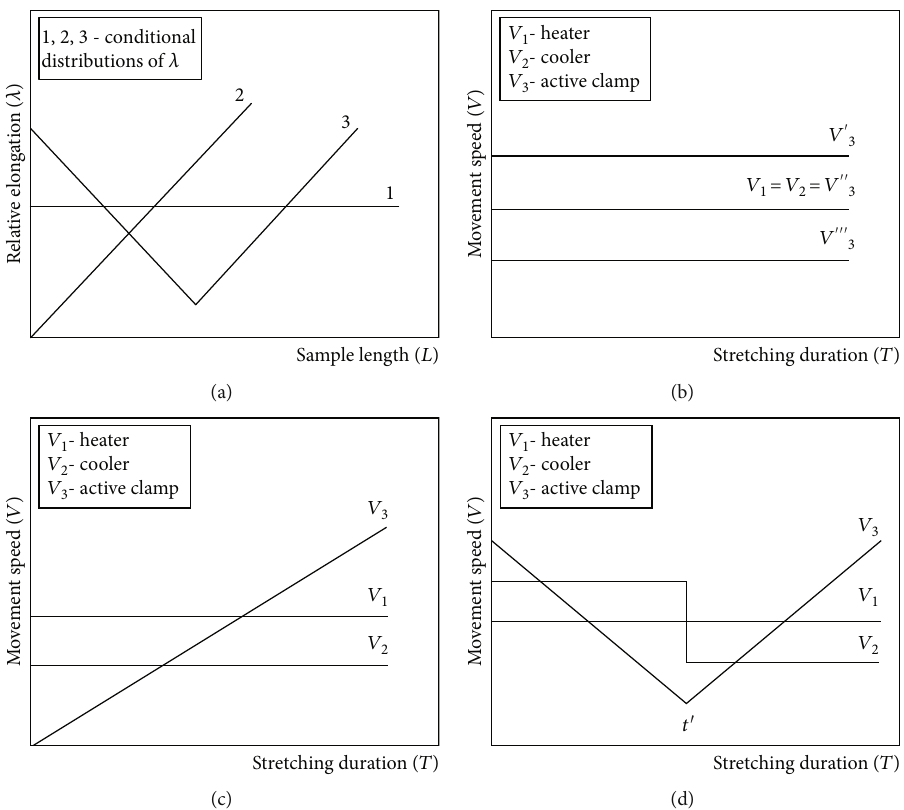
Figure 4: Creation of various distributions of relative elongation by appropriate combinations of motion speeds of zonal heater, active cooler, and active clamp. (a) Three cases of di ff erent possible conditional distributions of relative elongation λ that must be created along the length L of the isotropic sample. (b – d) Dependences of motion speeds ( V ) of the heater, active cooler, and active clamp on the duration of the stretching process ( T ), which realize the distribution of relative elongations along the length L of the isotropic sample corresponding to curves 1, 2, and 3 in